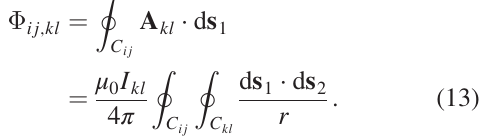
FIG. 4. Dependence of B 0 on Δ B